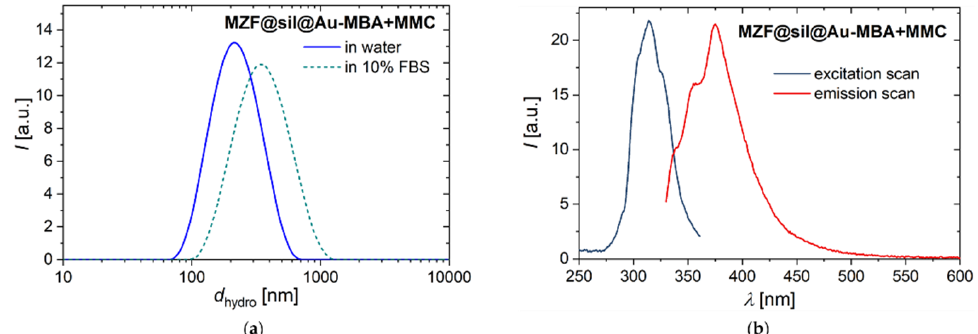
Figure 9. ( a ) The intensity-weighted hydrodynamic size distribution of MZF@sil@Au-MBA+MMC nanoshells in pure water and 10 vol% FBS measured by DLS. ( b ) Fluorescence spectra of MZF@sil@Au-MBA+MMC particles in an aqueous suspension with pH = 7. The excitation scan was recorded at λ em = 375 nm, and the emission scan was measured with λ ex = 314 nm. 1 H NMR relaxometry showed that the MZF@sil@Au-MBA+MMC nanoshells repre-